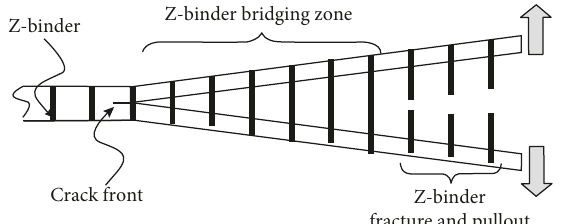
Figure 4: Yarn damage in the thickness during pull-out test of multilayer woven structure [21].